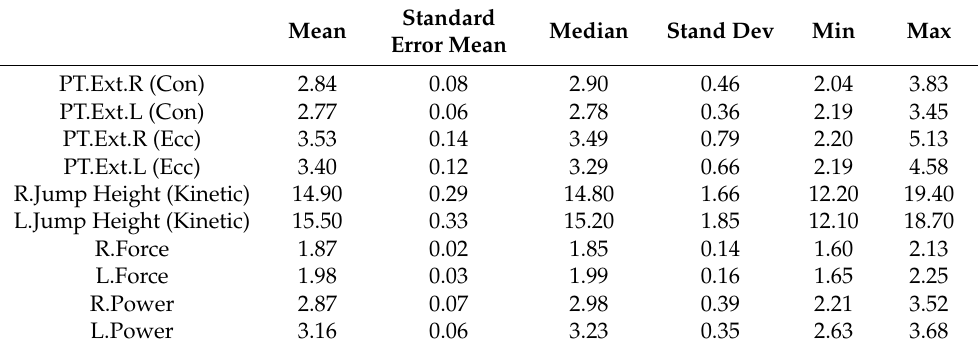
Table 2. Descriptive data of study sample, showing average values of all isokinetic and unilateral countermovement jump variables normalized by body